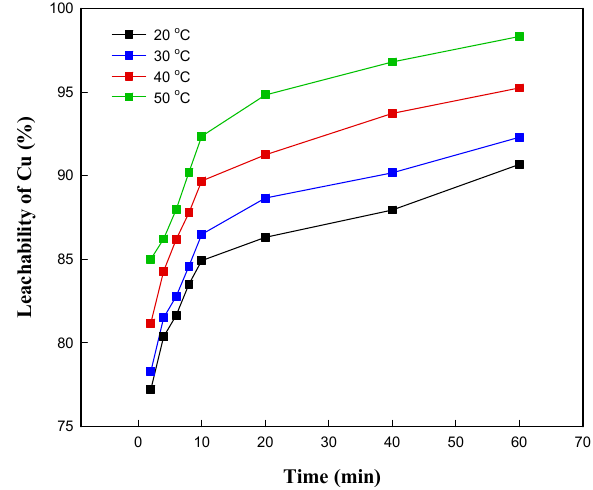
Figure 6. E ff ect of temperature and time on Cu Figure 6. Effect of temperature and time on Cu leachability . Figure 6. Effect of temperature and time on Cu leachability .